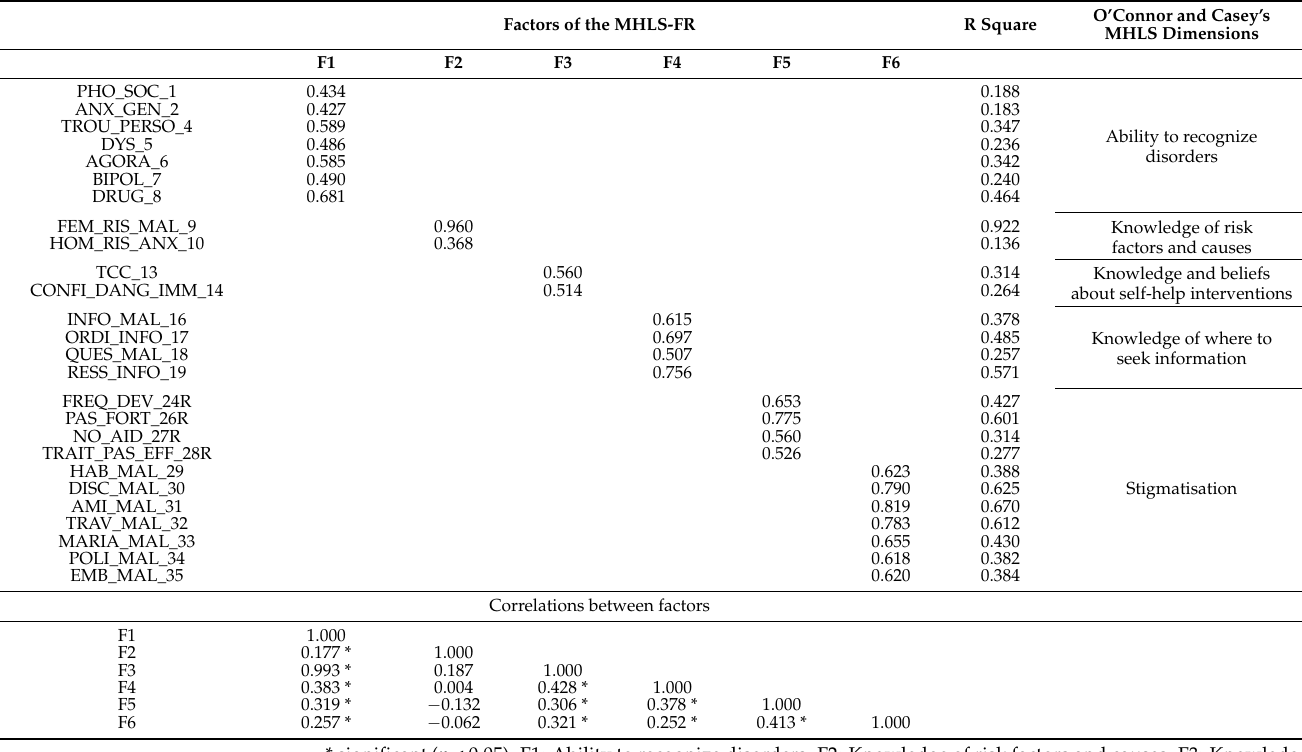
Table 3. Final MHLS-FR version with 26 items and 6 factors.